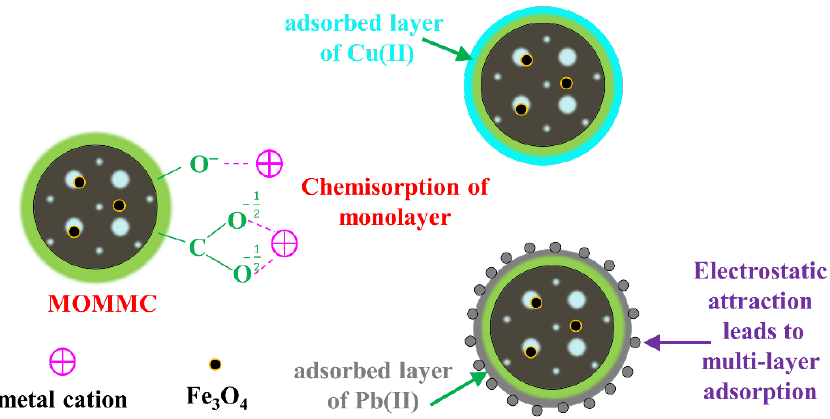
Figure 14. Proposed adsorption mechanism of Cu( Ⅱ ) and Pb( Ⅱ ) on MOMMC.